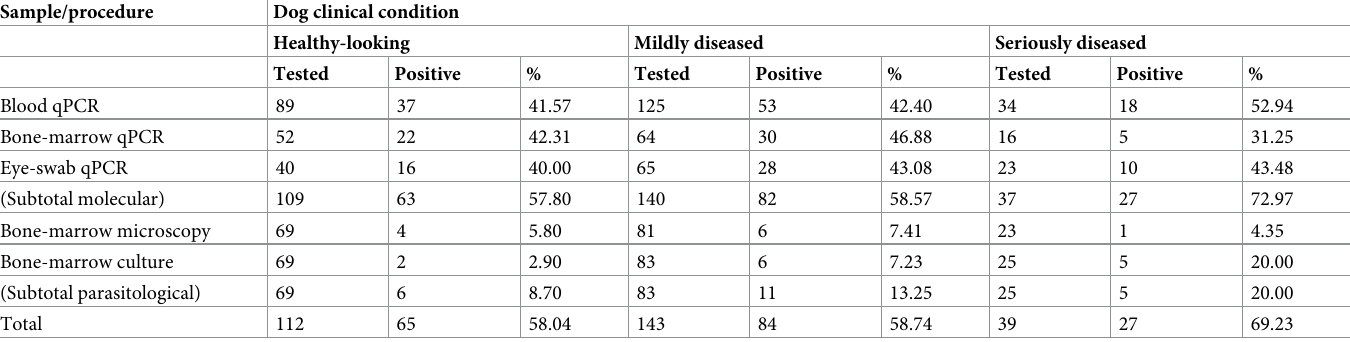
Table 6. Leishmania detection/non-detection in dogs from central-western Brazil: Results stratified by biological sample/diagnostic procedure and dog clinical condition.